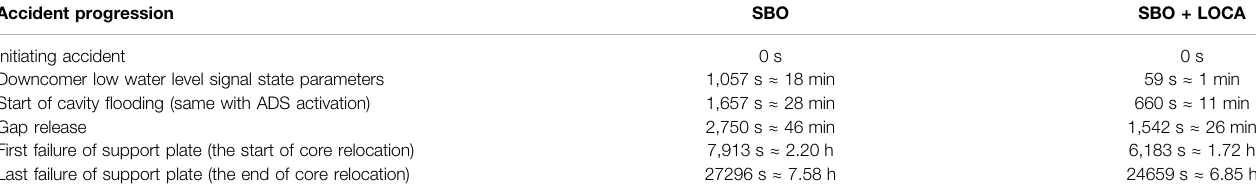
TABLE 3 | Accident progression for the case with deactivated failure modes in MELCOR. Accident progression Initiating accident